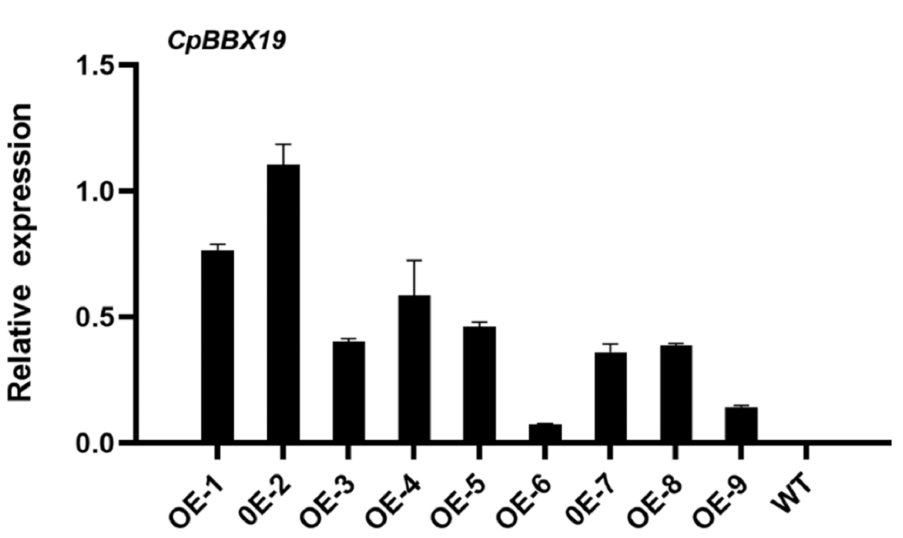
Figure 5. qRT-PCR identification of CpBBX19 transcript levels in the leaves of nine overexpressing Arabidopsis lines and WT plants. AtActin was used as the internal reference gene. Bars indicate the SE of the mean from three technical replicates and three biological